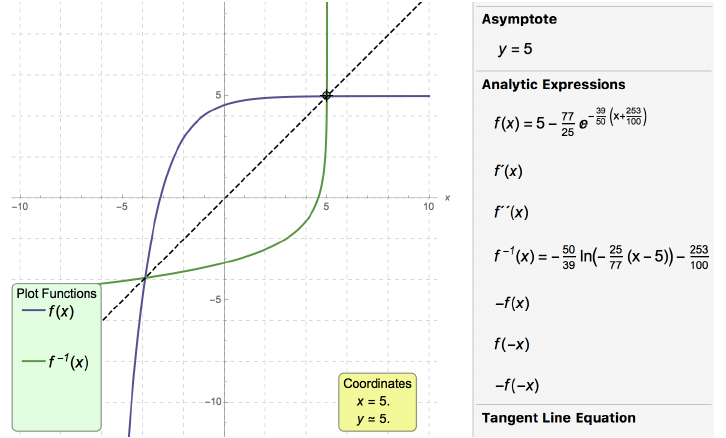
Figure 21. Image that illustrate the solution of the evaluation task that can be associated to Figure